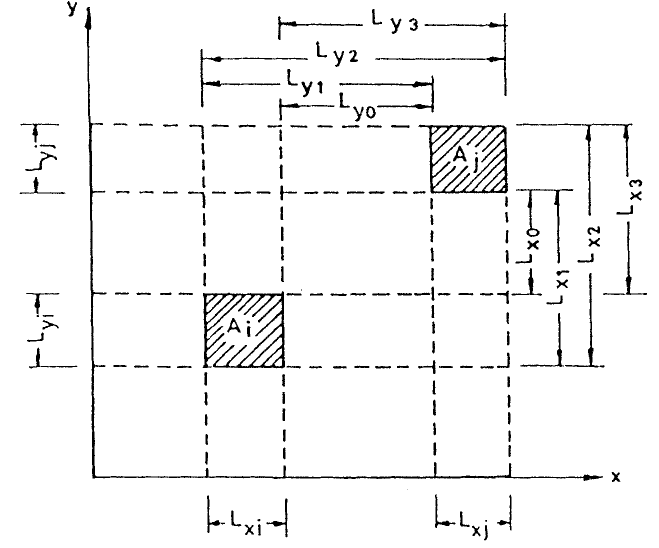
Fig. 1. Definition of distances characterizing relative positions of rectangles A i and A j